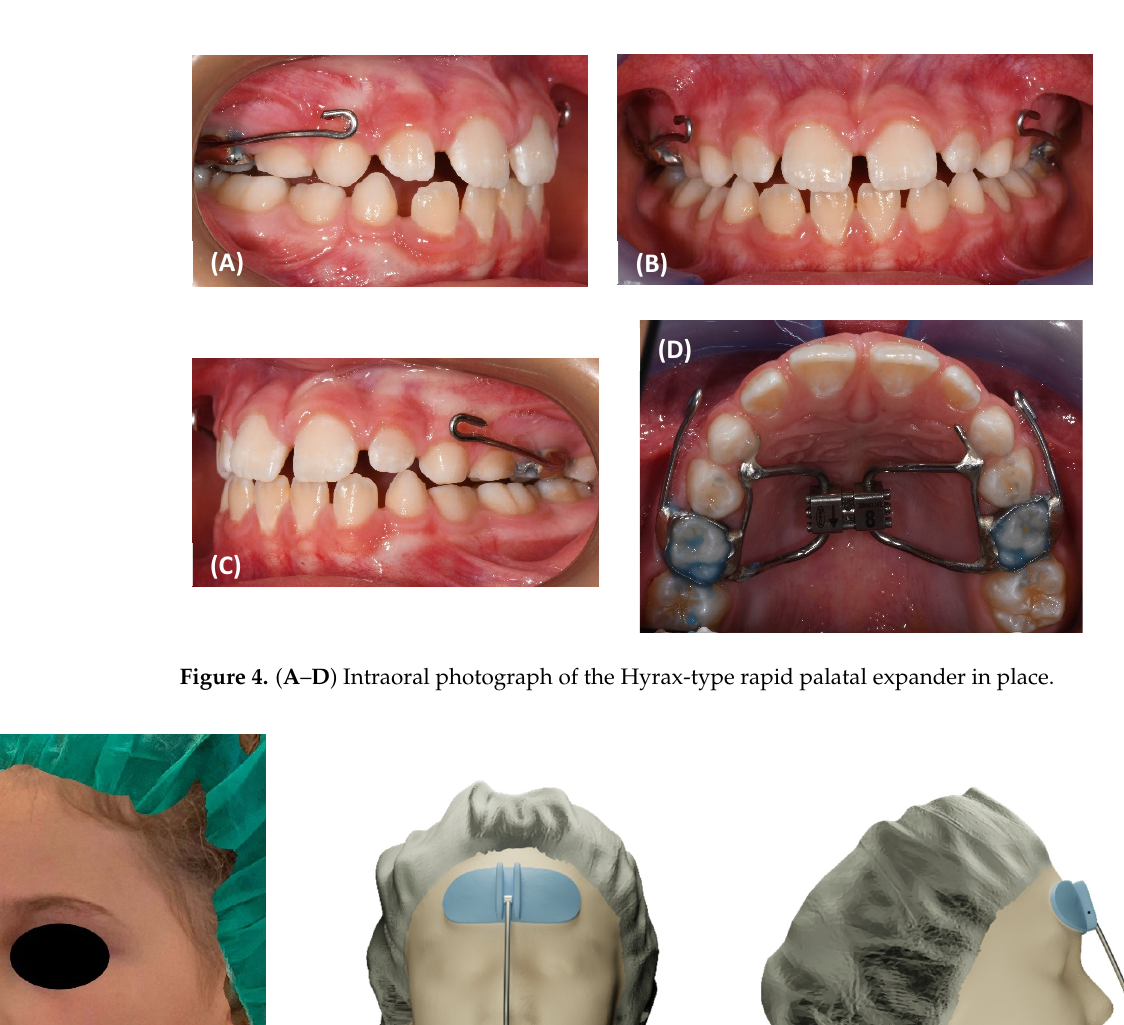
( B ) Figure 3. Pretreatment ( A ) and posttreatment ( B ) lateral cephalogram. Table 1. Cephalometric analysis. Variables Normal Values